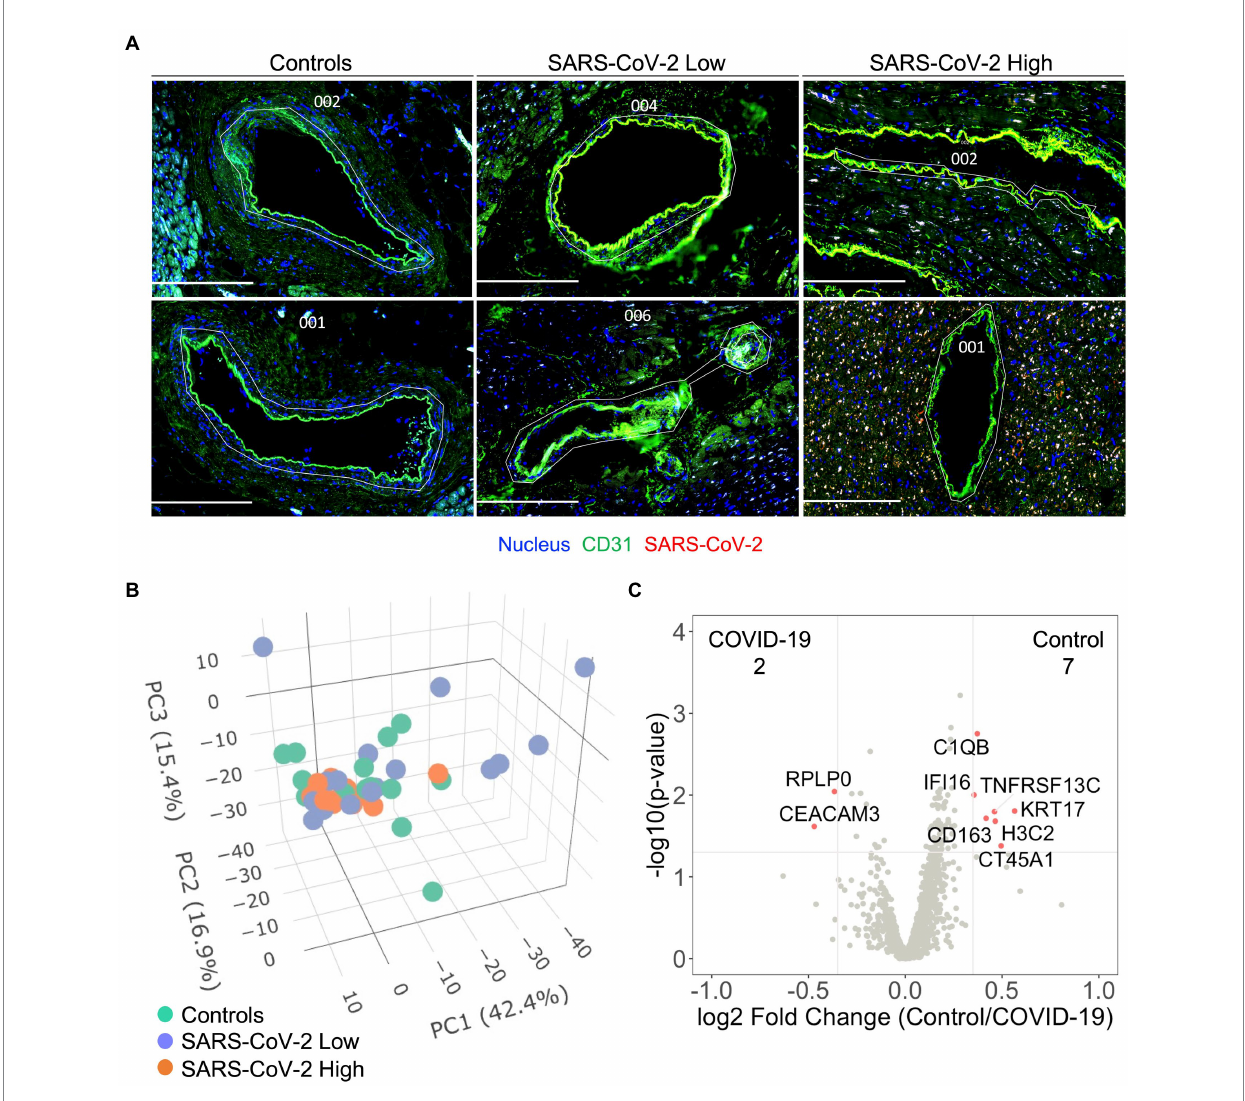
FIGURE 2 Severe COVID-19 is not associated with differential programming of the coronary arterial or venous endothelium. Coronary vascular endothelial cells were identified by immunofluorescence and selectively sampled for spatial transcriptomics (A) , white custom tracings illustrate representative replicate ROIs. In addition to control samples, COVID-19 patient samples were stained for SARS-CoV-2 nucleocapsid and stratified into quartiles based upon relative MFI with the bottom quartile defined as SARS-CoV-2 “Low” and the top quartile defined as SARS-CoV-2 “high.” 1,302 genes were above the limit of quantification. Despite marked heterogeneity in SARS-CoV-2 expression, principal component analysis failed to show pattern clustering (B) . Similarly, minimal differences in transcriptional programming were observed as only nine genes were observed to be differentially expressed between control and COVID-19 coronary endothelium (C) , data include ROIs from SARS-CoV-2 low and high samples. Differential gene expression was defined as p = 0.02 and log2 fold change of 0.4. COVID-19 ( n = 8 patients, 30 ROIs) and Control ( n = 4 patients, 15 ROIs). Scale bars are 250 μ m for each